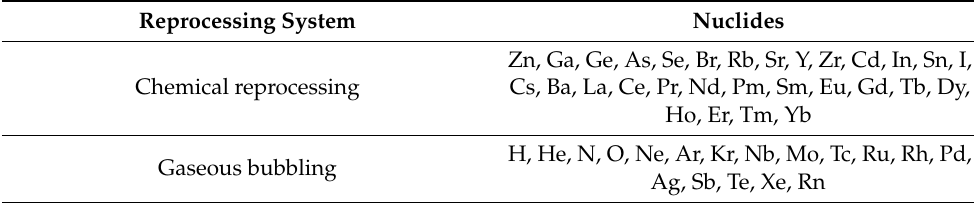
Table 2. Reprocessing system of